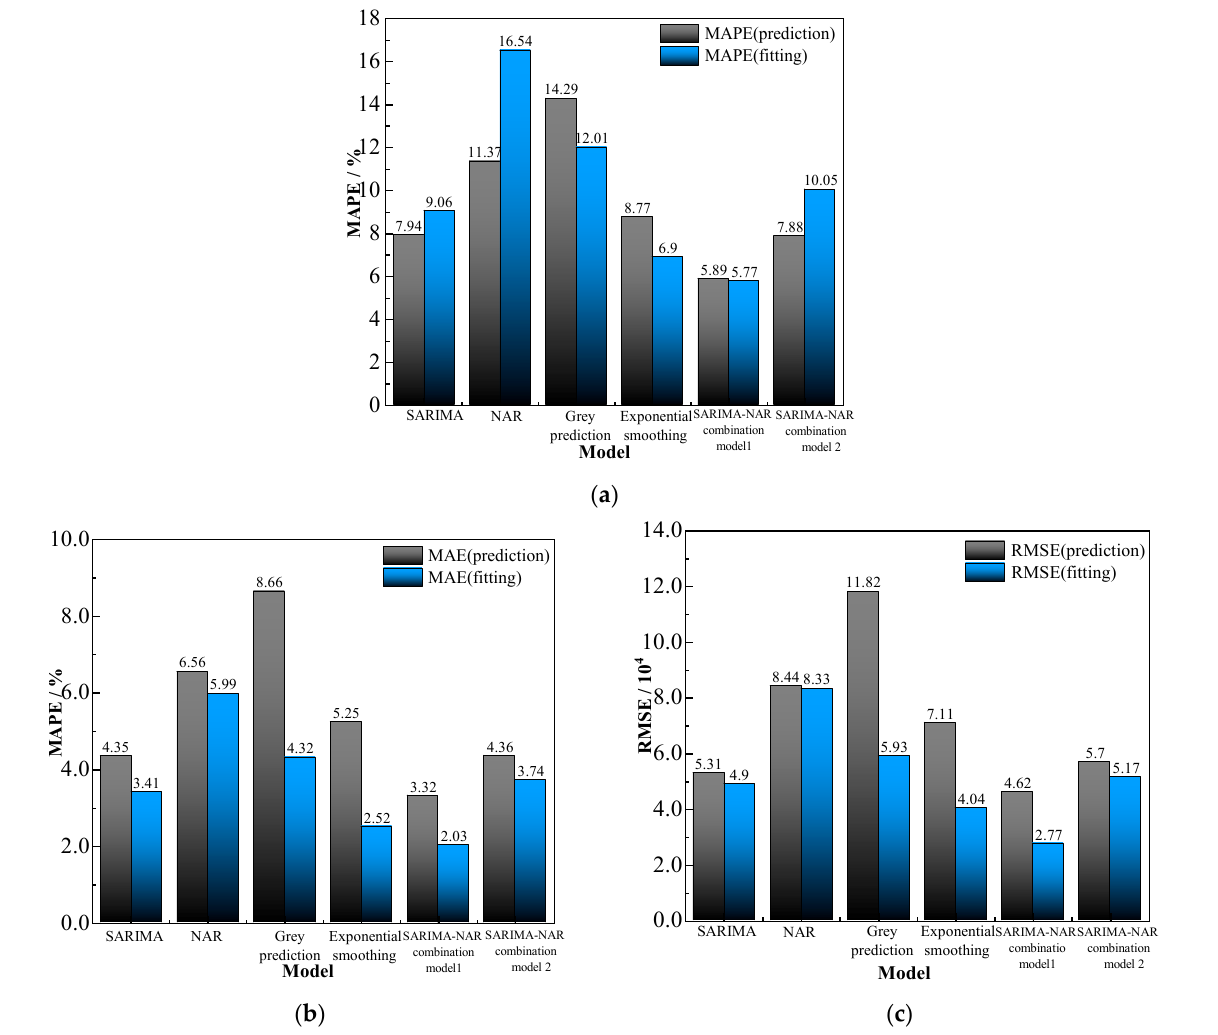
Figure 10. Error statistics of fitting and prediction. ( a ) MAPE, ( b ) MAE, ( c ) RMSE.